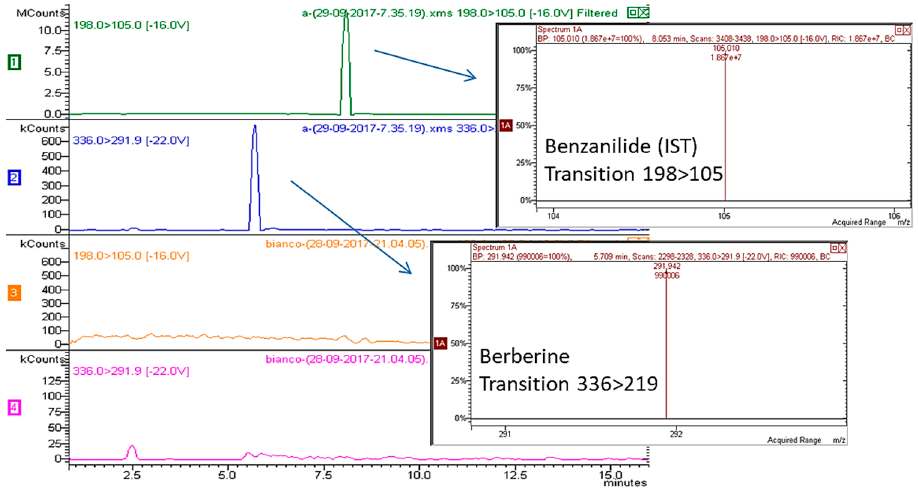
Figure 1. HPLC-MS/MS chromatogram of plasma spiked with ISTD and berberine and blank plasma.